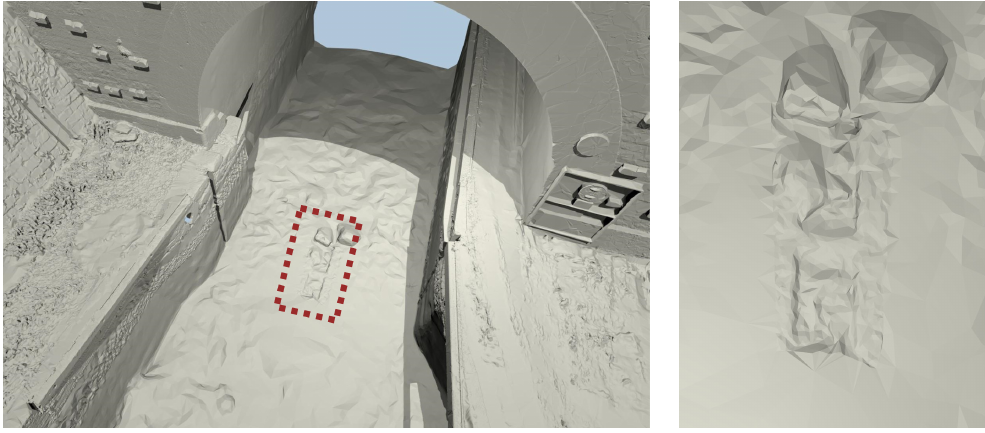
Figure 21. Close-up of the reference model showing two blocks and some structure in the alignment of the cofferdam grooves, which seem similar to the one observed in 2009 at Arzviller (Figure